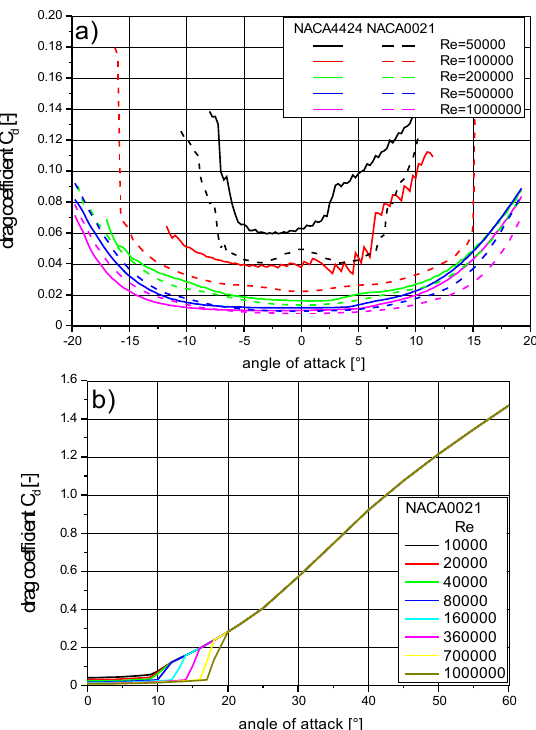
Figure 7. Dependence of drag coefficient on the angle of attack [53–55]. ( a ) the drag coefficient of the airfoil NACA0021 for small angles of attack ( b ) the drag coefficient of the airfoil NACA0021 for high angles of attack